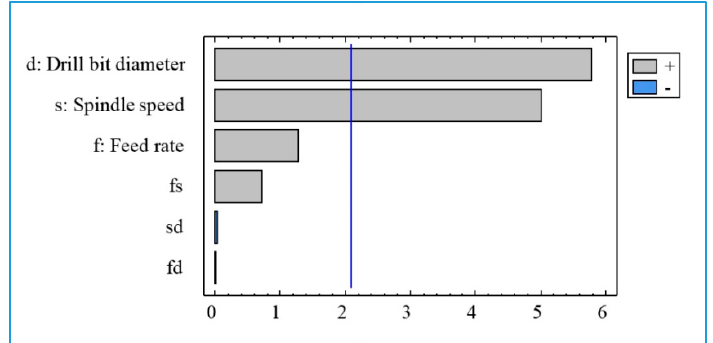
Figure 13. The chart of the effects for the surface roughness R t .